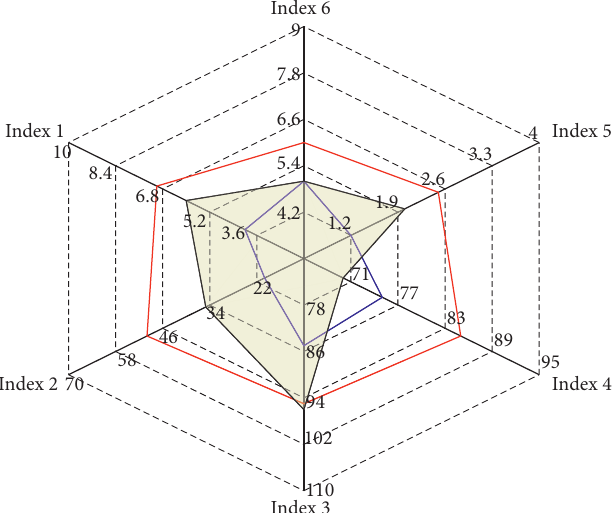
Figure 3: The distribution of Internet of Things information characteristic